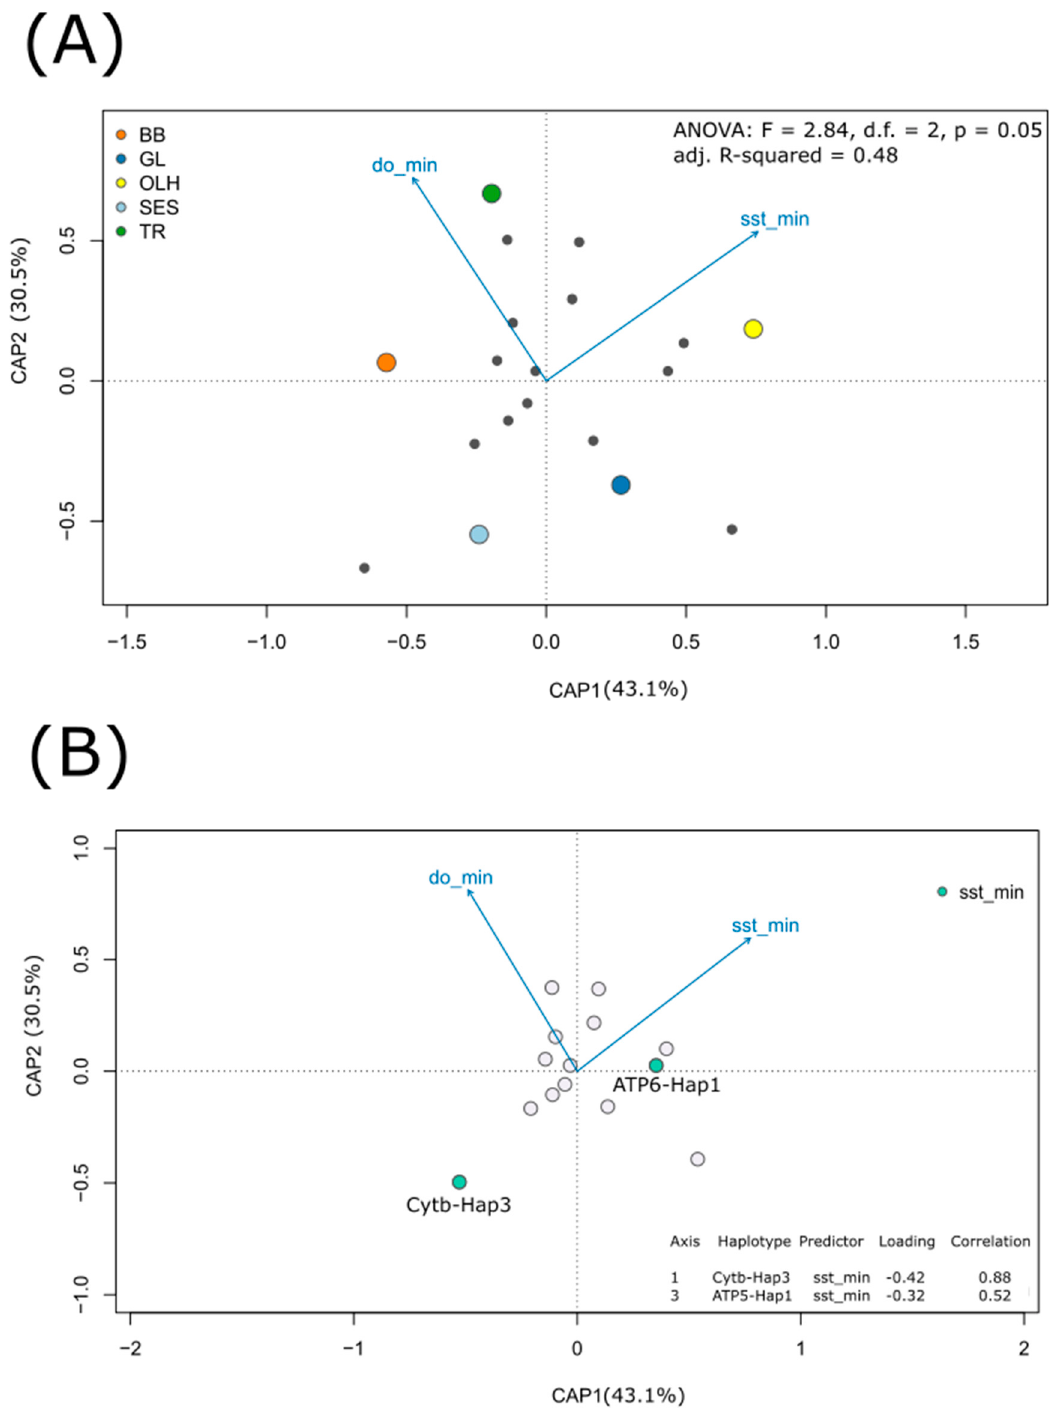
Figure 3. Presentation of redundancy analysis ordination with minimum values of environmental variables. ( A ) Ordina- tion plot with haplotypes (response variables) as grey dots, populations in coloured dots and environmental variables (explanatory variables) as vectors. BB = Bay of Biscay, GL = Gulf of Lion, TR = Tarragona, OLH = Olhão, SES = Sesimbra; sst_min = minimum sea surface temperature, do_min = minimum dissolved oxygen. ( B ) Ordination plot highlighting haplotypes, Cytb-Hap3 and ATP6-Hap1, whose frequency is predicted to vary with minimum sea surface temperature (Cytb-Hap3: r = 0.88, p < 0.05; ATP6-Hap1: r = 0.52, p < 0.05), also showing respective axis and correlation coefficients.